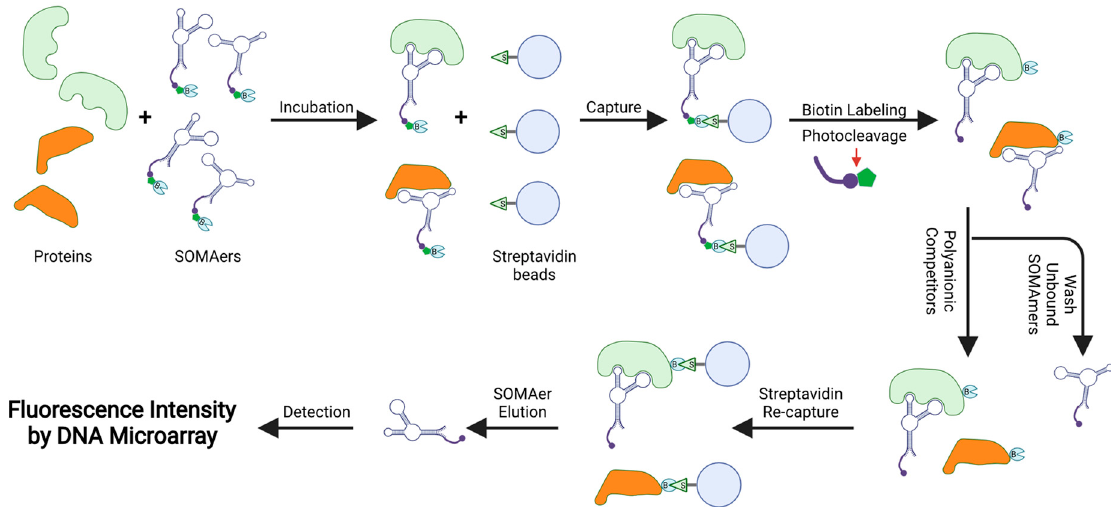
Figure 5. Schematic overview of the SOMAscan analysis. Each SOMAmer contains a biotin (B) group, a photo-cleavable link, and a fluorescent tag at the 5 (cid:48) end. SOMAmers are mixed with the test sample, forming SOMAmer–protein complexes. The complexes are captured on streptavidin beads via strong biotin–streptavidin interaction. The captured proteins are then biotinylated and the SOMAmer–protein complexes are released from beads using ultraviolet light. Polyanionic competitors are added to promote the dissociation between proteins and non-specific SOMAmers. The SOMAmer–protein complexes are recaptured on new streptavidin beads. Protein-bound SOMAmers are eluted, hybridized to custom arrays of SOMAmer-complementary oligonucleotides, and quantified by fluorescence intensities, which are proportional to the concentrations of their cognate target